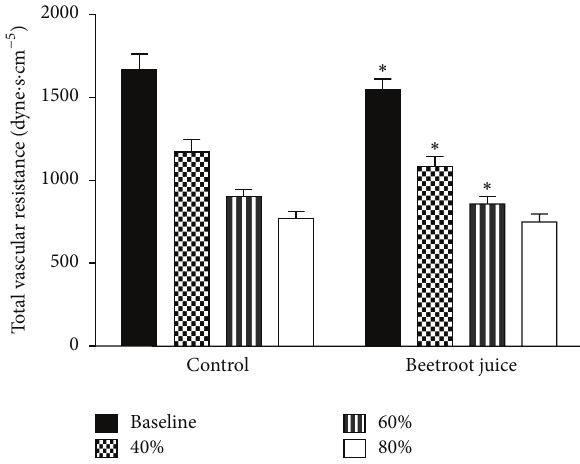
Table 3: Effects of beetroot juice treatment at submaximal exercise.